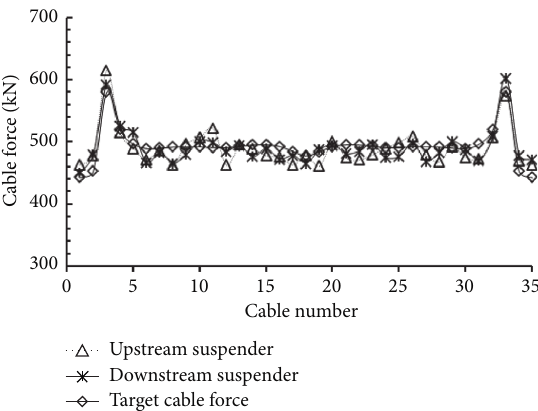
Figure 7: Plot comparison between measured and designed suspender tension at completion